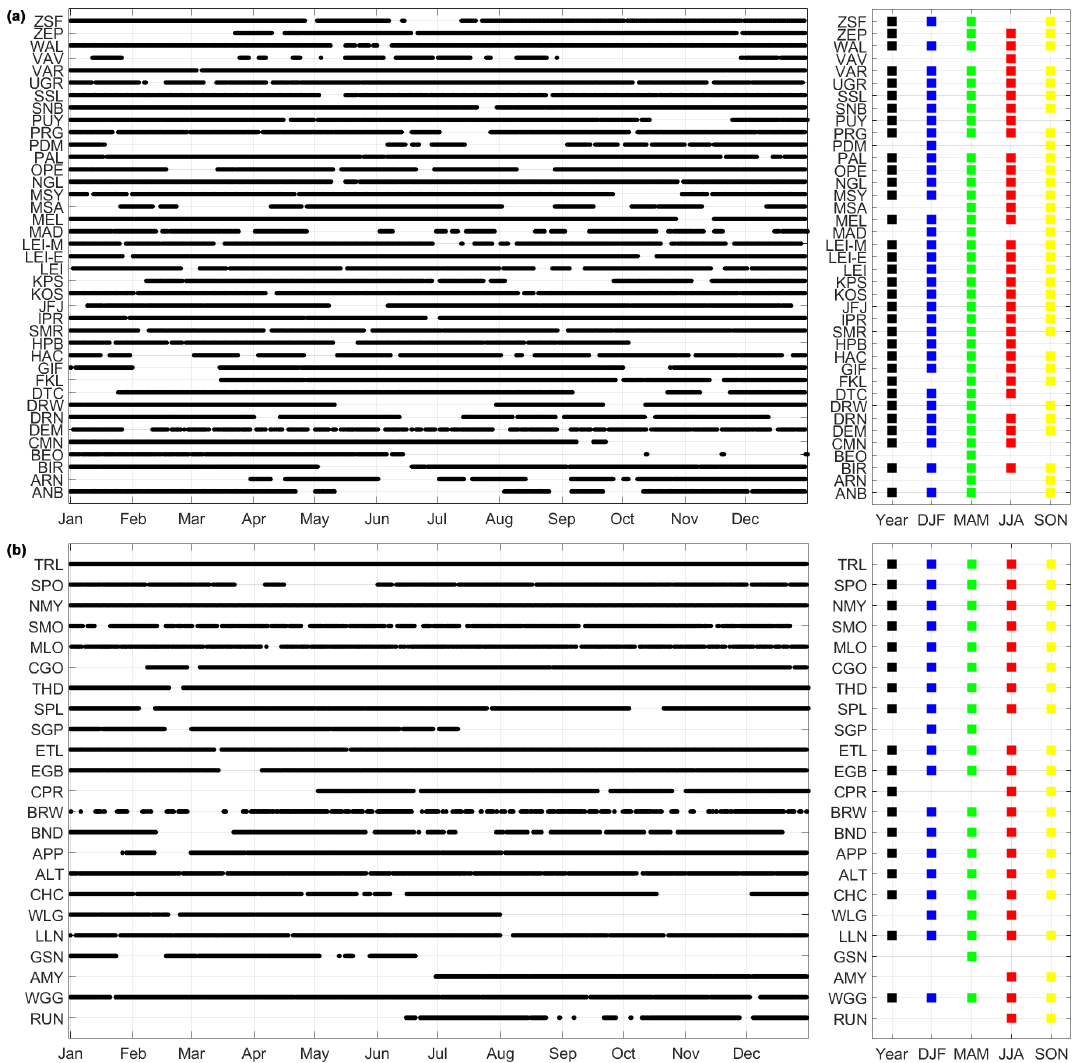
Figure 2. Data coverage of the sites. For clarity, (a) European and (b) remaining stations are shown separately. Black dots on the left panel indicate the presence of valid hourly data, and markers on the right panel indicate the periods (year and seasons) for which the corresponding data availability was sufficient to compute statistics (i.e. 50% for seasons and 60% for the full